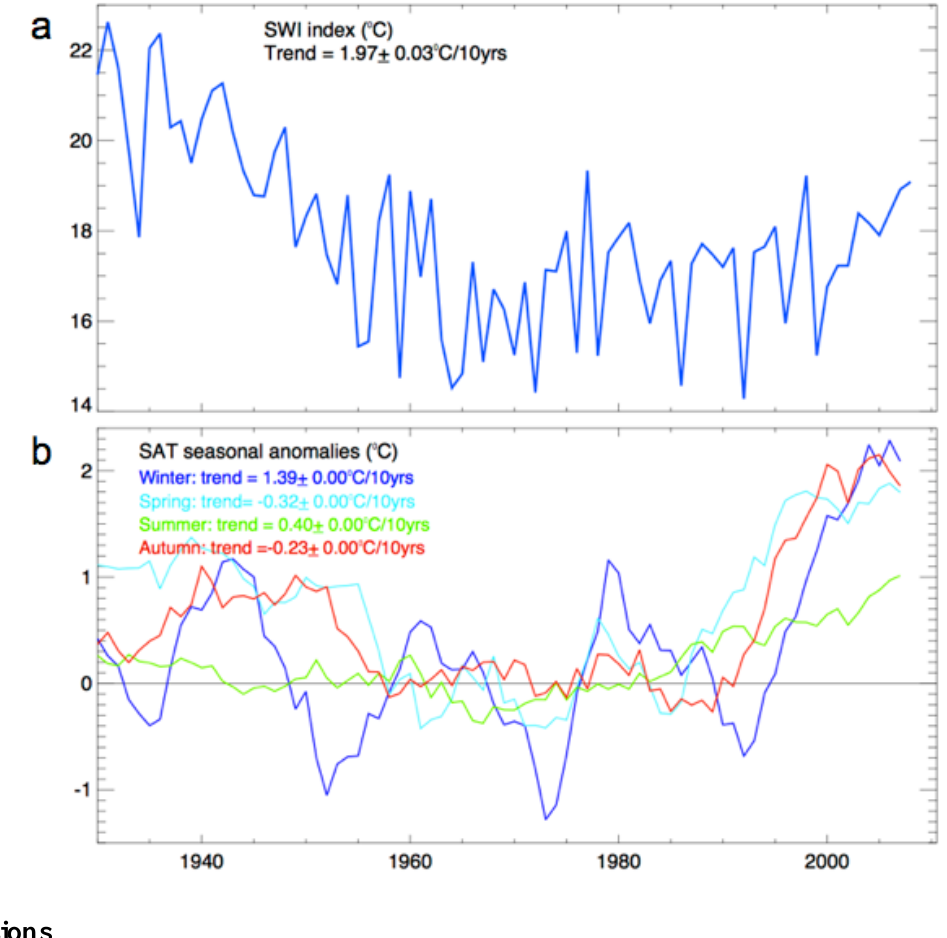
Figure 9. Time series of ( a ) SWI and ( b ) seasonal surface air temperature (SATs) anomalies for North America based on 2-m air temperatures from meteorological stations (see locations in Figure A1b). Trends shown in the panels are for the period 1982–2008. The x-axis for both panels is shown at the bottom of the